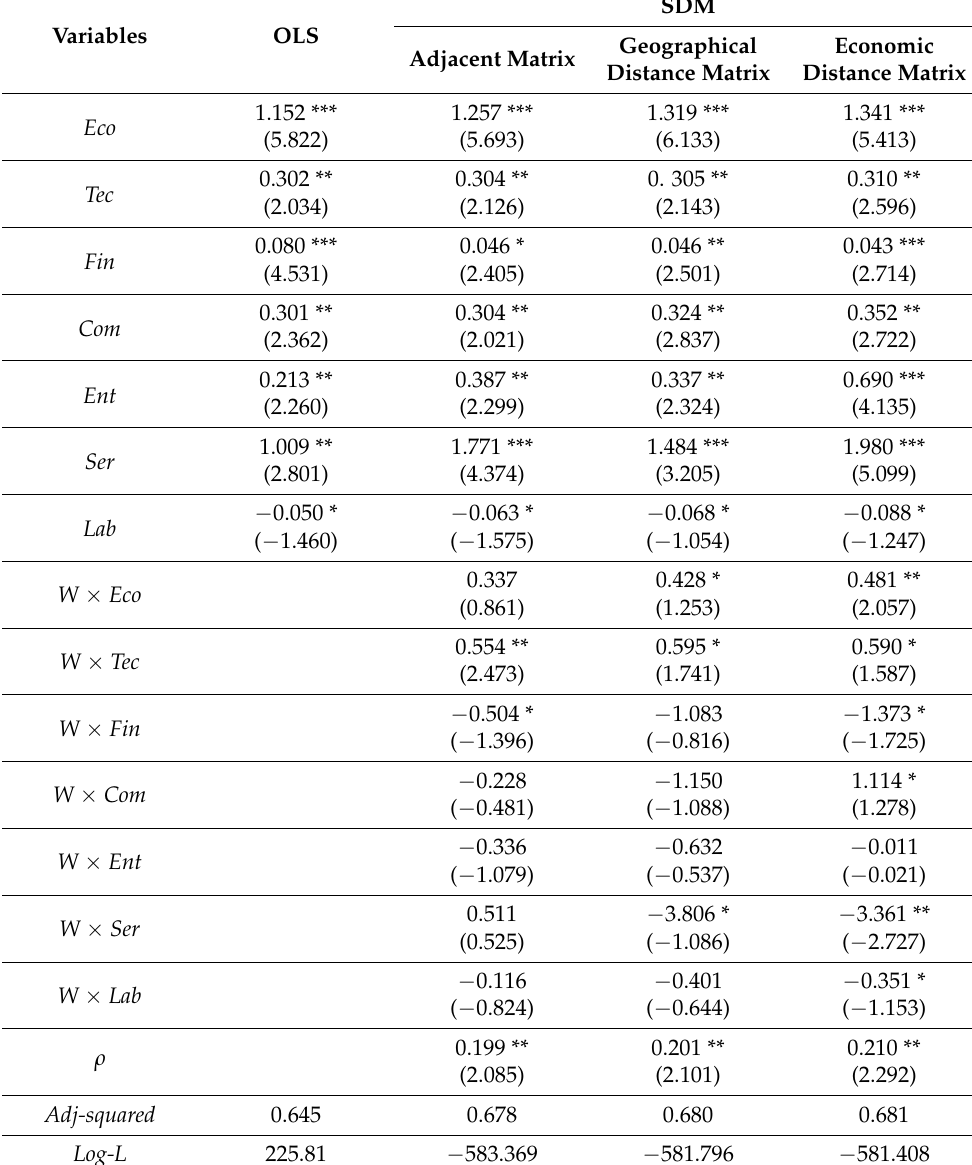
Table 4. The regression results based on three spatial weight matrices and the spatial durbin model.